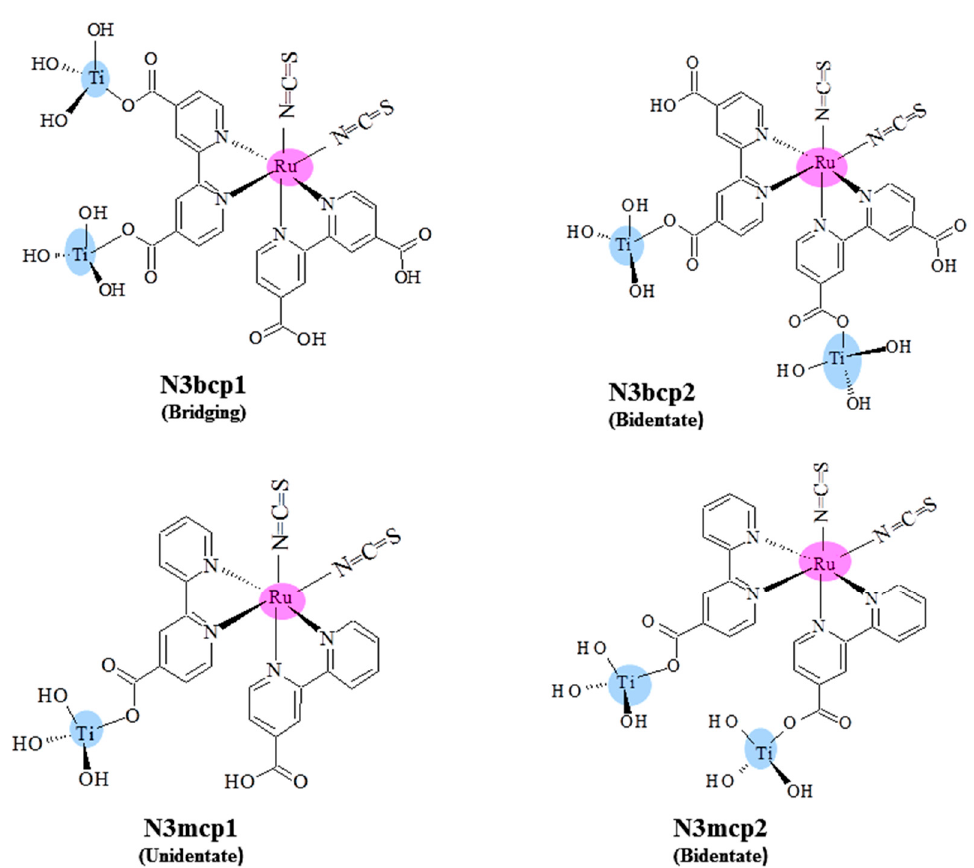
Figure 37. DoLAc structure for the N3 mono a di carboxi complex showing three binding modes.